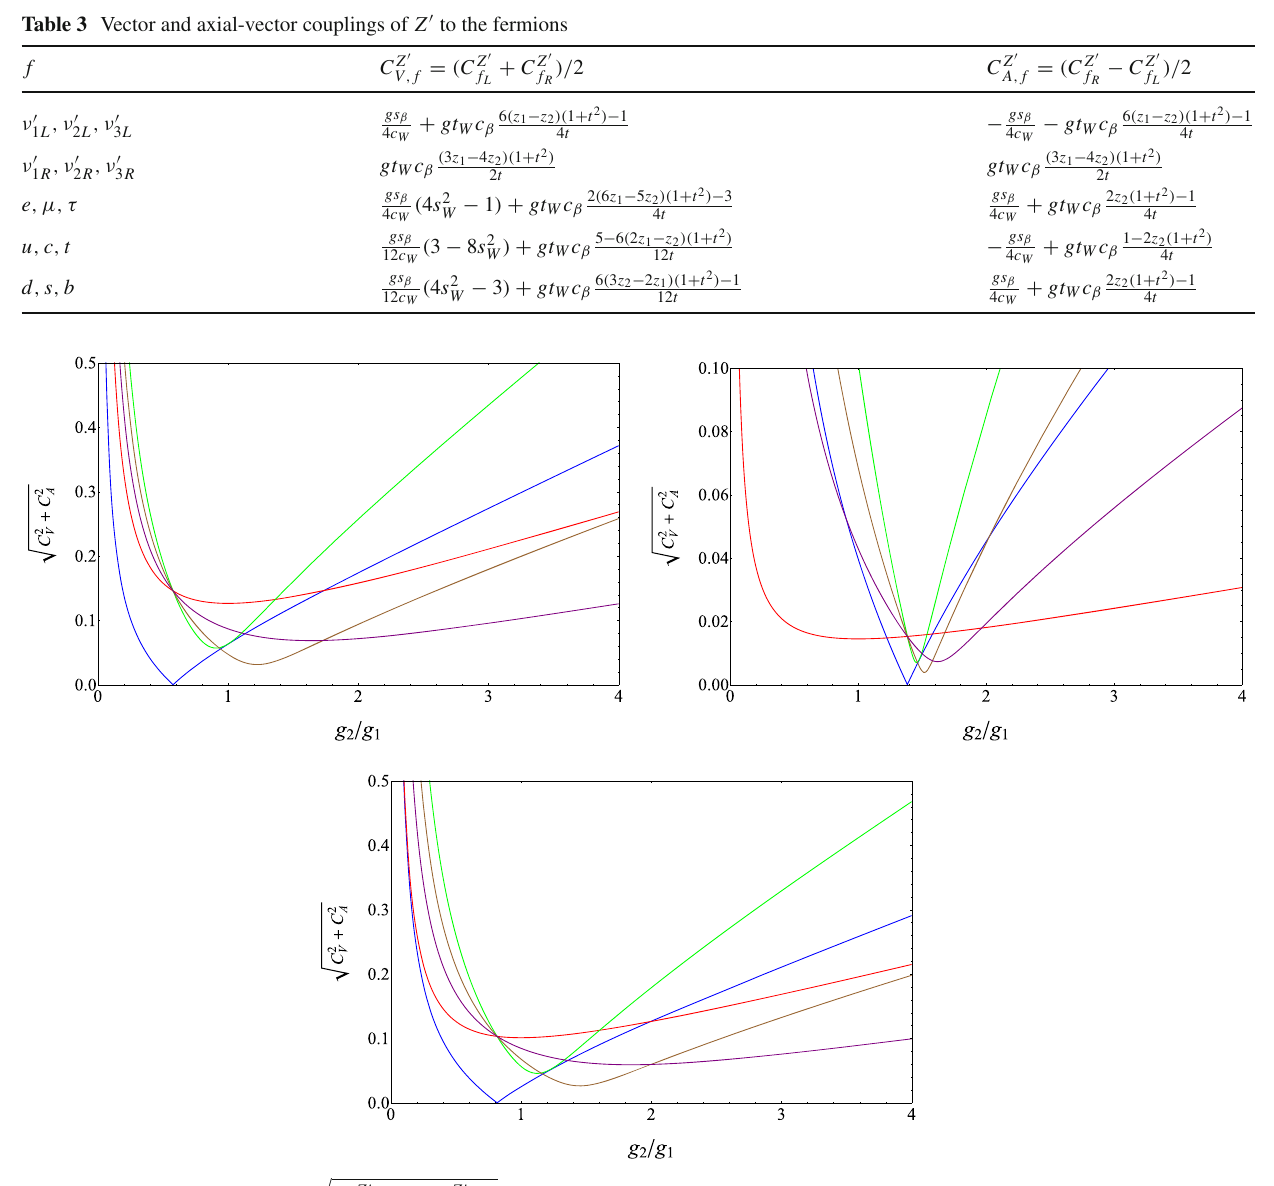
Fig. 1 The Z (cid:2) coupling strength of the ratio g 2 / g 1 for several values of z 1 and z 2 . The blue, red, green, brown, and purple curves corresponding to ν (cid:2)